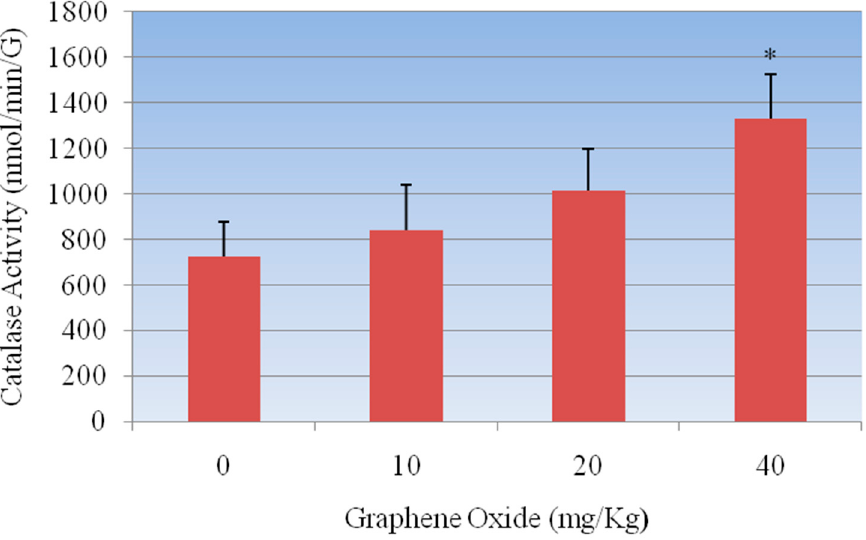
Figure 4. Effect of GOs on CAT activities in kidneys of rats after 5 days. Each bar represents mean ± SD of five rats. Values with asterisks were significantly different from control. Statistical significance ( p < 0.05) is depicted as ( * ).